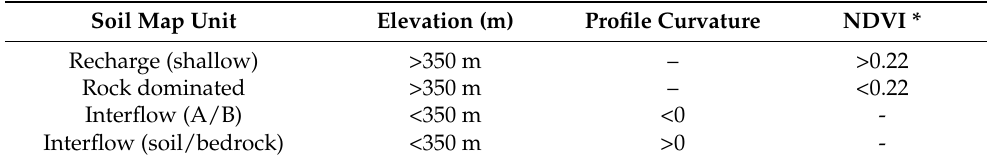
Table 4. The SoLIM rules used to create the